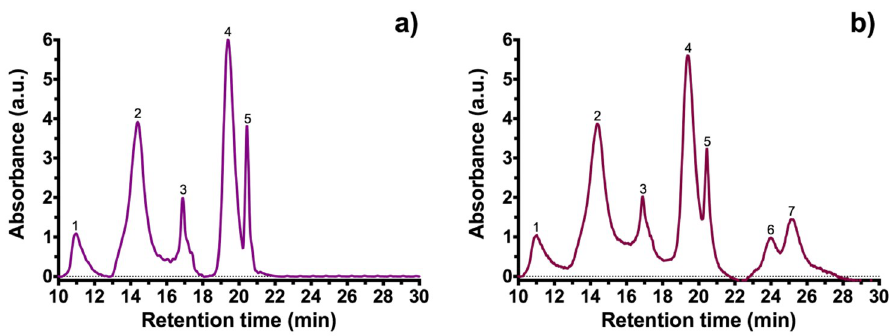
Figure 2. High performance liquid chromatography (HPLC) of black carrot extracts: ( a ) sample BCS (extracted with ethanol/citric acid). ( b ) sample BCA (extracted with ethanol/acetic acid). Peaks were identified and are shown in Table 1.